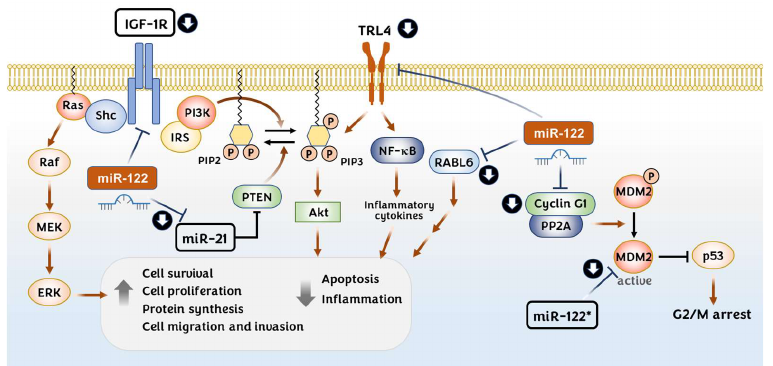
Figure 2. Regulation of the insulin-like growth factor 1 (IGF-1) receptor (IGF-1R); Toll-like receptor 4 (TRL4); RAB, member RAS oncogene family-like 6 (RABL6); and p53 signaling pathways by miR-122. The activated IGF-1R transduces a signal via the Ras-MAPK and PI3K/Akt pathways to enhance cell survival, proliferation, and protein synthesis while inhibiting apoptosis during hepatocellular